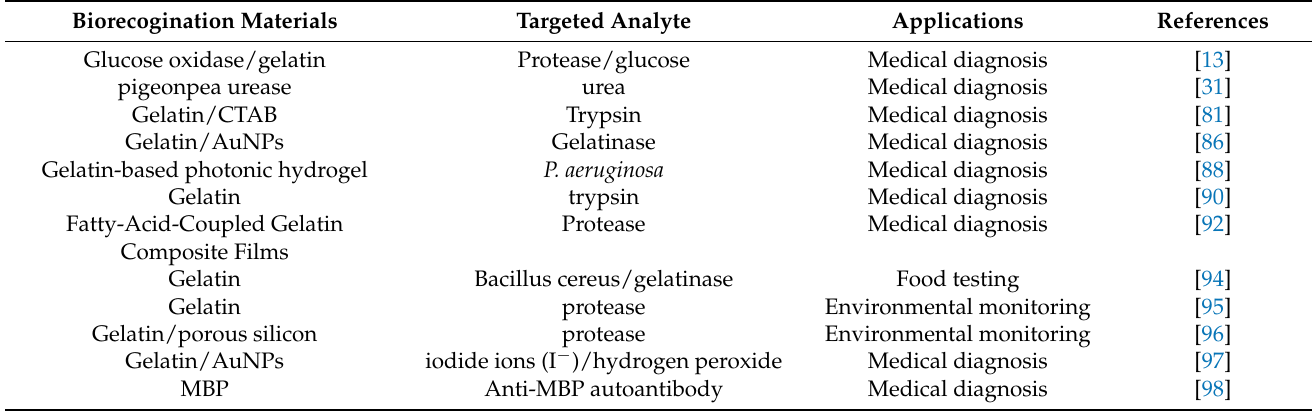
Table 2. Biosensors with gelatin as biorecognition material for detecting target analytes. Biorecogination Materials